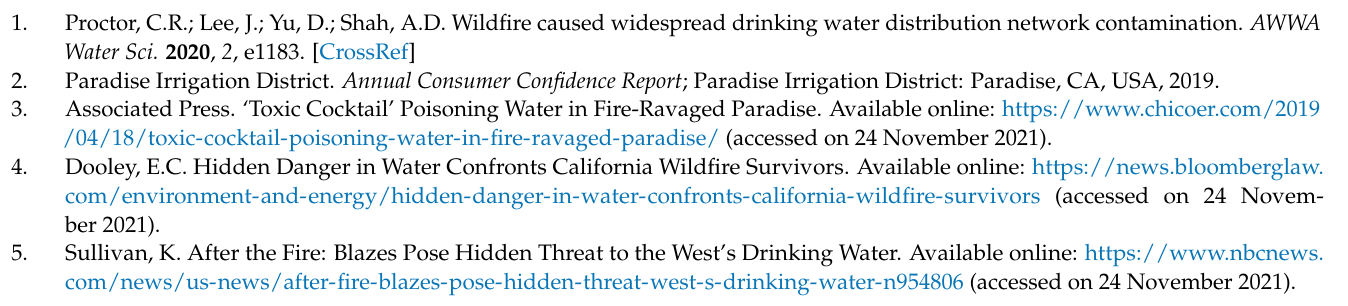
Table S1. Participant responses about the results return communications and the study, Paradise